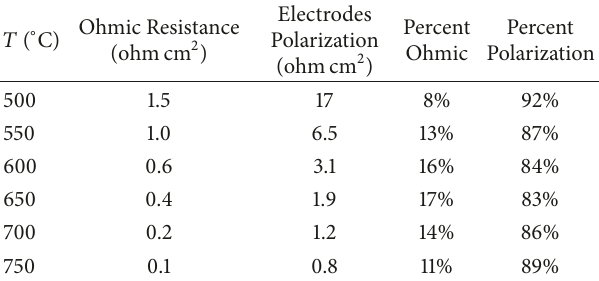
Table 1: Ohmic resistance and electrodes polarization estimated from the impedance data shown in Figure 7.